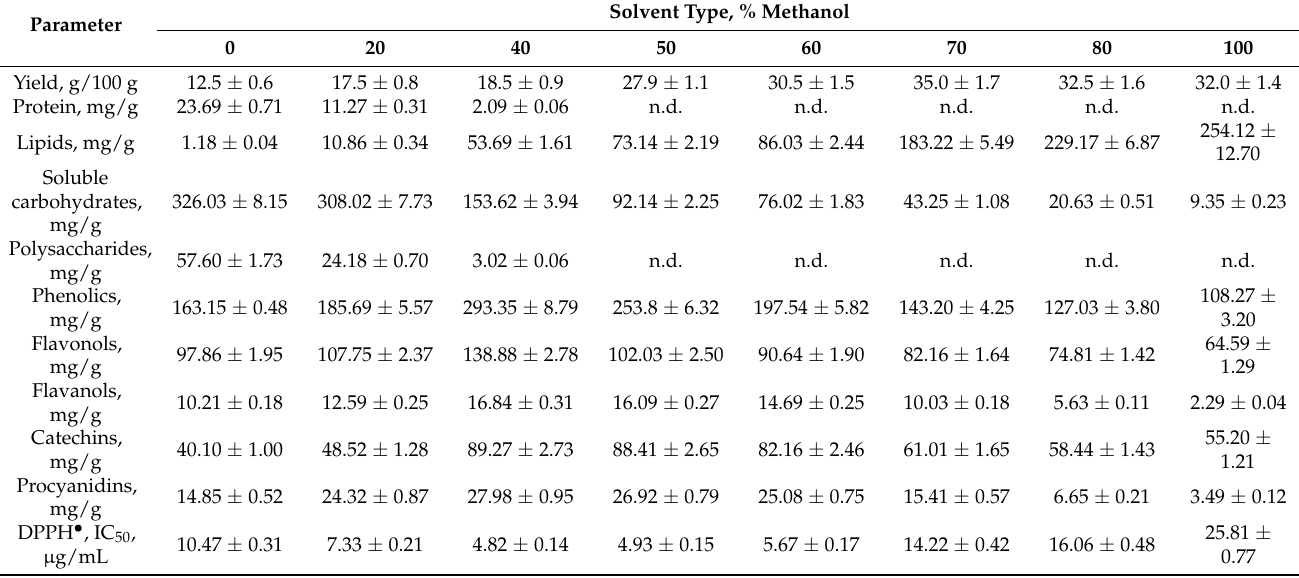
Table 2. Chemical composition and DPPH • scavenging activity of R. adamsii leave extracts, ± S.D.